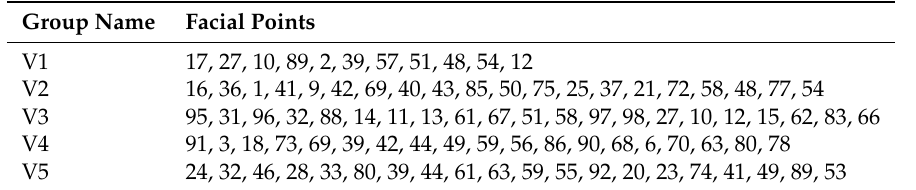
Table 6. Groups created with facial points.